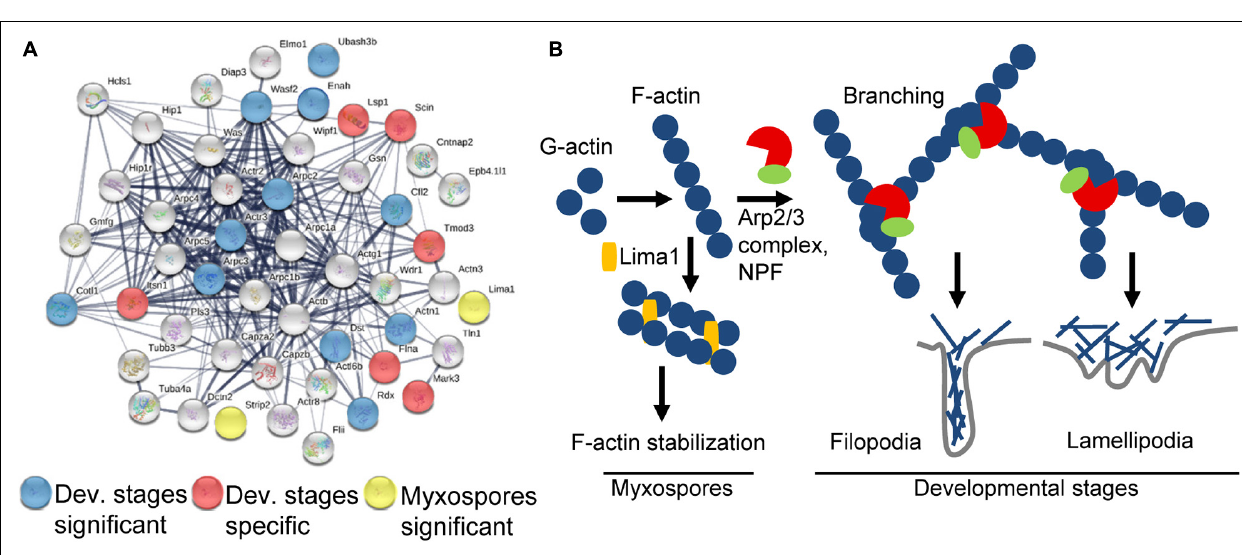
FIGURE 5 | Schematic representation of the actin-related proteins. (A) STRING interaction map of proteins having “actin” or “cytoskeleton” GO term or annotation in both datasets. The STRING data were obtained using mouse protein homologs of C. shasta and the mouse symbols are near the nodes. Respectively, blue and red nodes represent proteins significantly expressed in or specific to developing spores, while yellow nodes represent proteins significantly expressed in mature myxospores. Gray nodes represent proteins common to both sample types. Strong associations are represented by thicker lines. (B) Key pathways found in mature myxospores and developmental stages. In developmental stages, F-actin is nucleated by Arp2/3 and NPFs to create branched actin, which promotes lamellipodia and filopodia formation that enable cell motility, whereas in mature myxospores F-actin is stabilized and nucleation is